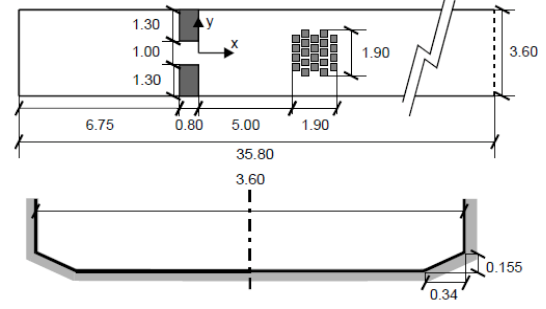
Fig. 1 . Experimental device, dimensions of the channel (me- ters) and simplified arrangement of the city (J. Lhomme et al., 2006) In this study, a Permanent flow (95 L / s) is simulated by keeping the door opened and pumping water from one end to the other of the channel. A simplified city is arranged in the channel with a staggered arrangement of buildings. The coef- ficient of Strickler channel is equal to100